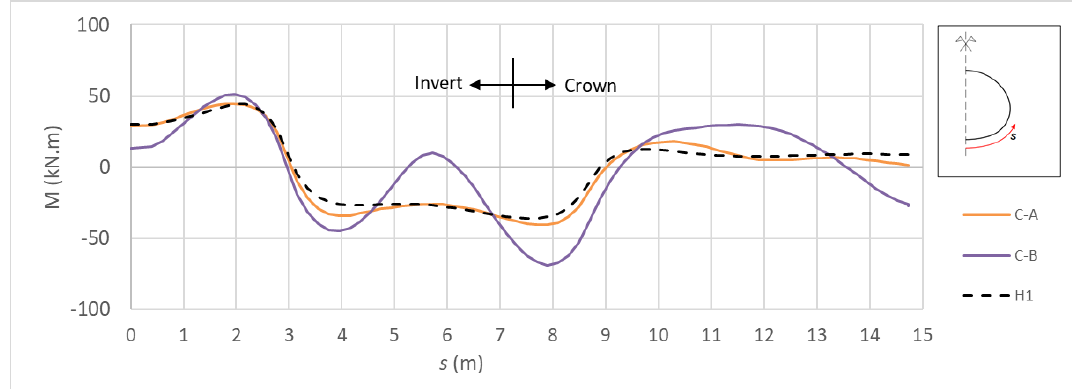
Figure 3. Comparison of bending moment beam load results for varying complexity of calibrated